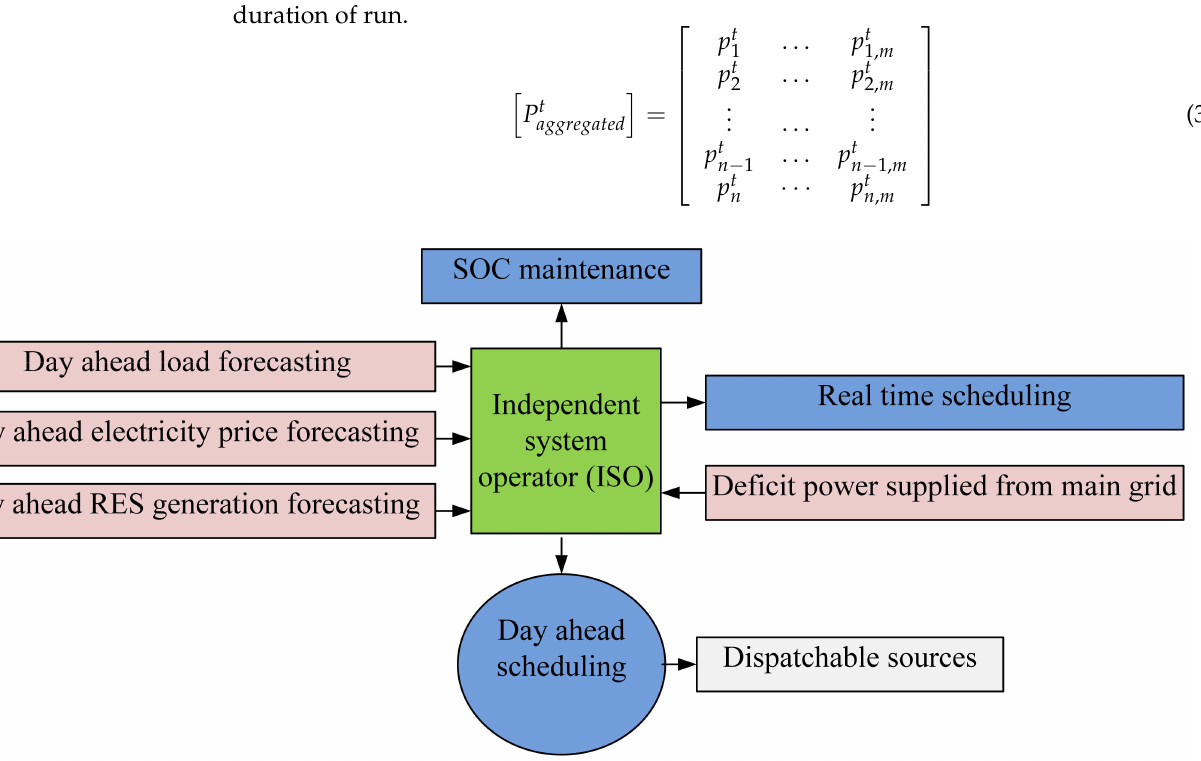
Figure 12. ISO function in load data collection, processing, and